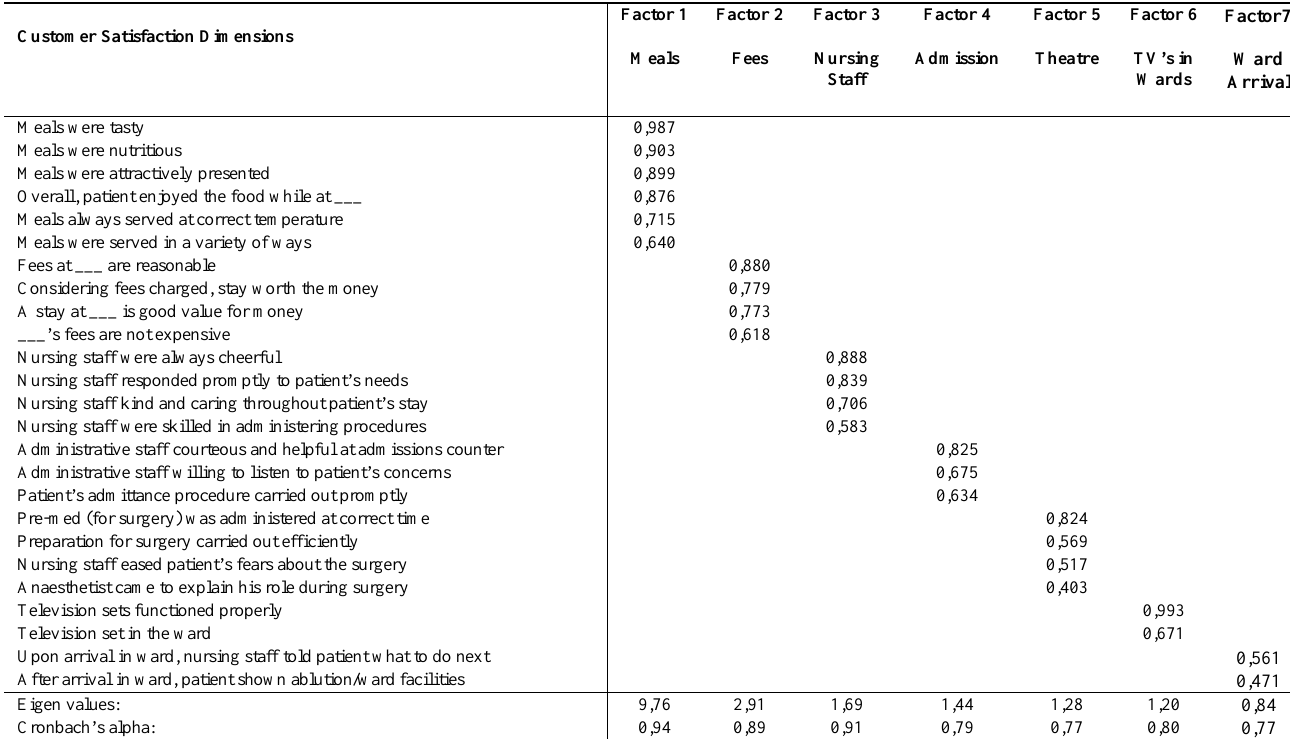
Table 2: Factor matrix for customer satisfaction items Customer Satisfaction